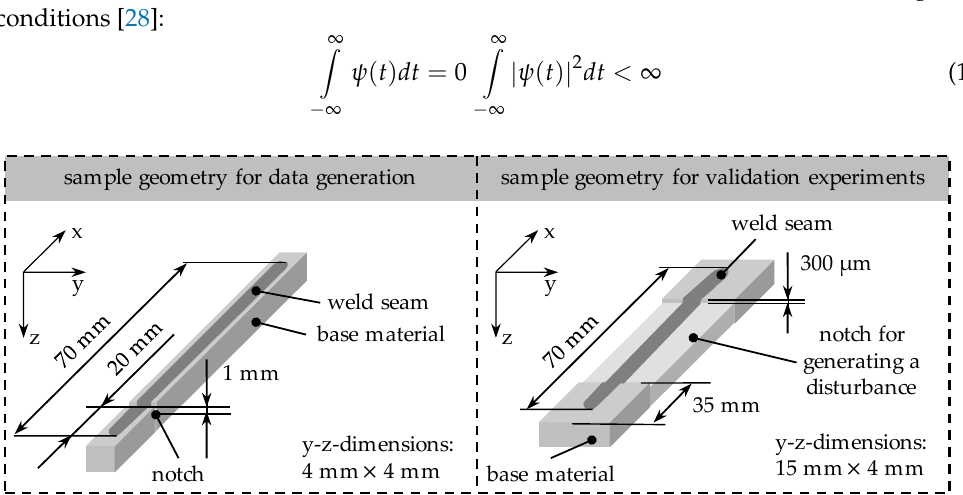
Figure 2. Specimen geometries for the welding experiments; ( left ) : specimen geometry for data generation by µCT with reference notch for the correlation of OCT data and the position of the record along the feed direction; ( right ) : specimen geometry for the validation of the weld depth control with a notch on the surface for the generation of a disturbance in the controlled system.